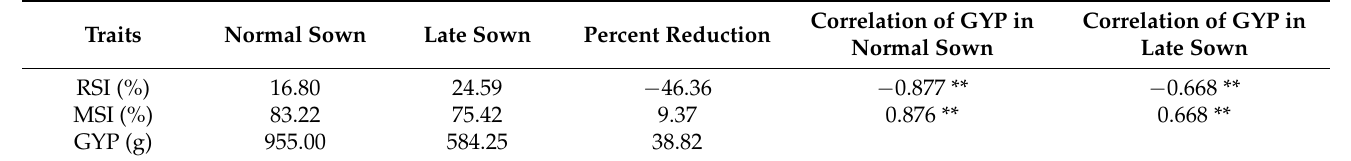
Table 1. Description of field parameters; RSI (relative stress injury), MSI (membrane stability index) and GYP (grain yield per plot) under normal and late sown conditions.